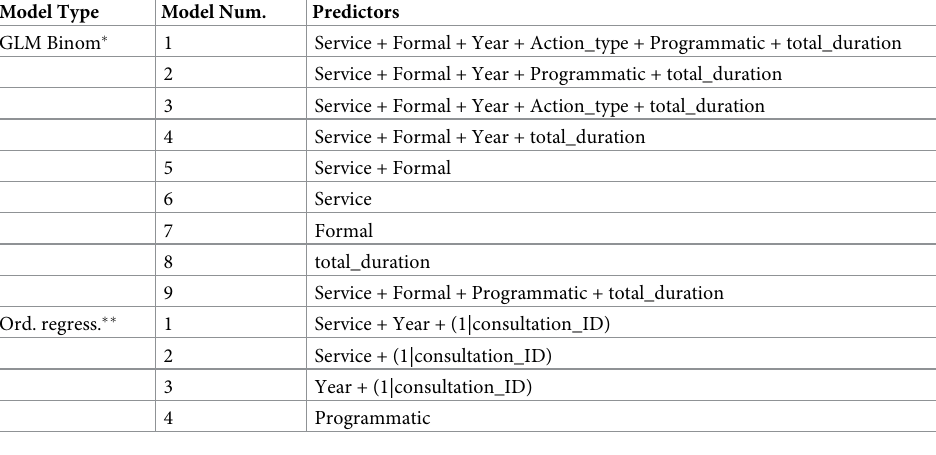
Table 1. Candidate generalized linear and ordinal regression models for predicting overall consultation complete- ness and conservation action specificity. Model